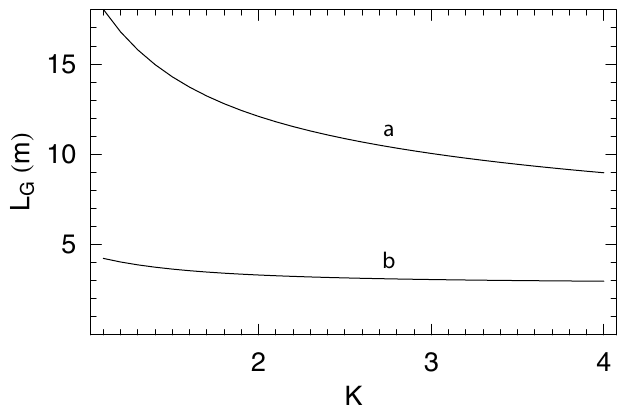
FIG. 1. Power gain length L of an x-ray FEL at 0 : 4 (cid:1)A versus G the undulator parameter K for (a) a beam with a normalized transverse emittance of 1 (cid:1) m and a peak current of 3.5 kA, and (b) a beam with a normalized transverse emittance of 0 : 1 (cid:1) m and a peak current of 1.0 kA. The electron beam energy in both cases is adjusted according to the FEL resonant condition, with the relative rms energy spread at 1 (cid:5) 10 (cid:1) 4